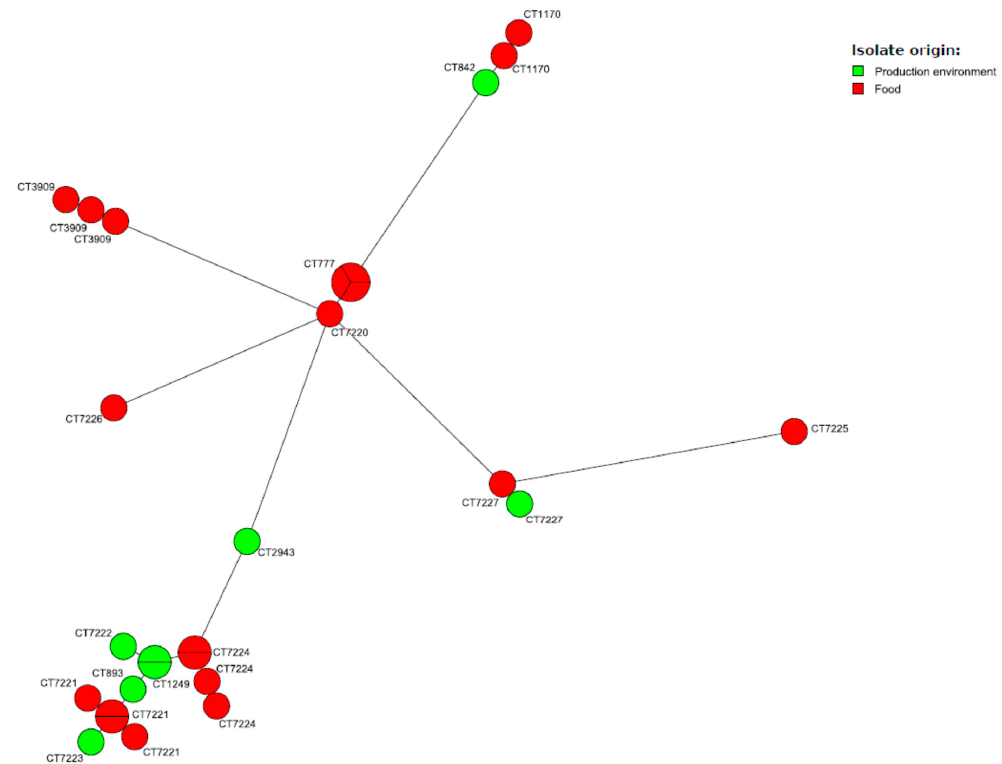
Figure 1. MST of cgMLST allelic profiles of 28 L. monocytogenes studied strains. cgMLST types (CTs) are represented by colored circles where size is proportional to the number of isolates.